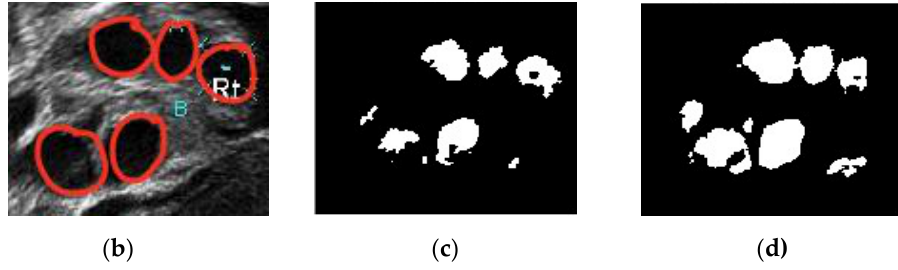
Figure 12. Comparison images of different segmentation methods. ( a ) Original ultrasound image; ( b ) follicles marked by medical expert; ( c ) classical Chan – Vese method; and ( d ) Otsu thresholding and the Chan – Vese method. and the Chan–Vese method.